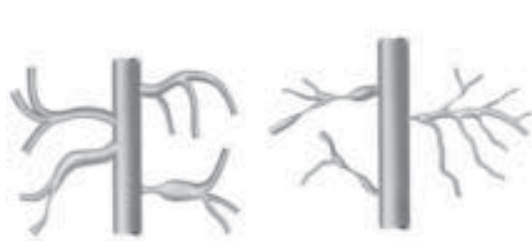
Fig. 4 - Schematic representation of subgroup C1 with thick and medium major aortopulmonary collateral arteries, without predominance of stenosis, supplying all the pulmonary lobes and of subgroup C2 with medium and fine major aortopulmonary collateral arteries with a predominance of stenosis, supplying all the pulmonary lobes.